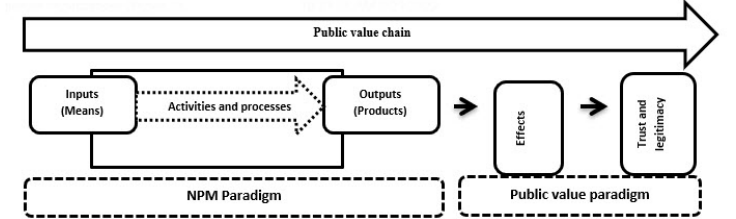
Figure 2. The public value chain as a mode of management and value creation for public organizations (source: authors’